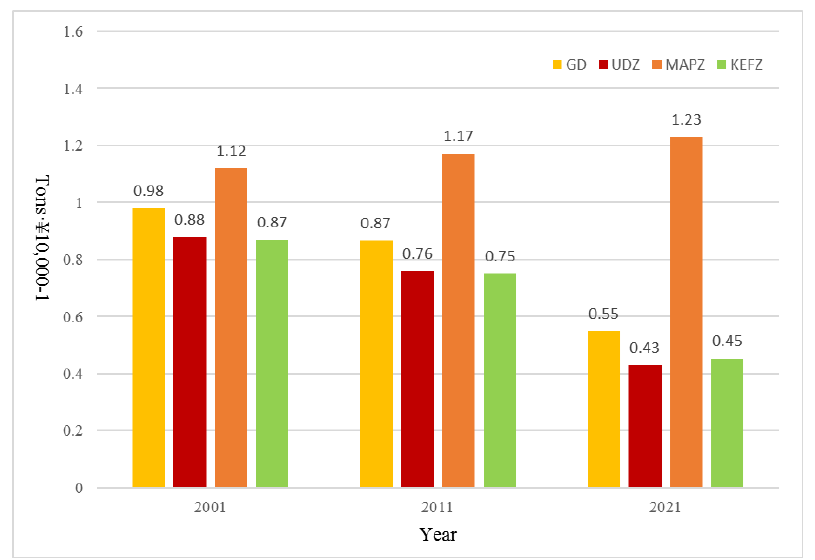
Figure 6. Changes in carbon emissions per unit GDP within Guangdong Province and for the three types of MFOZs from 2001 to 2021. types of MFOZs from 2001 to